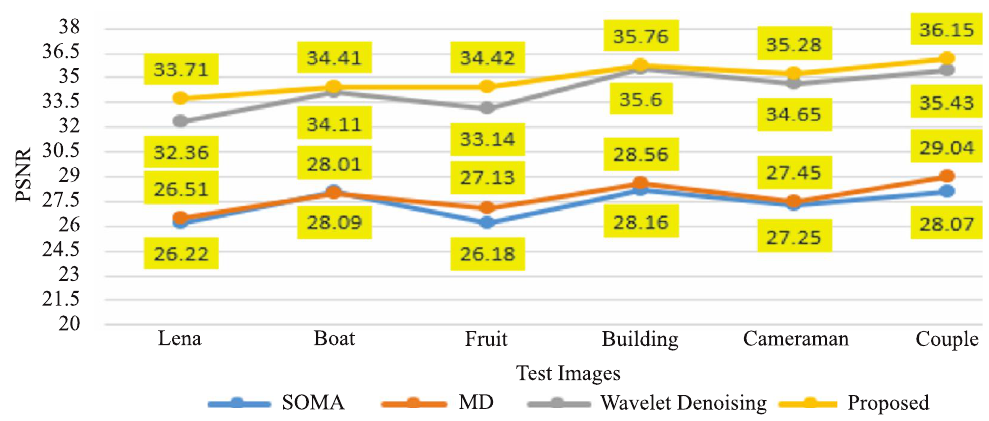
FIG. 9. GRAPHICAL COMPARISON OF PSNR OF DIFFERENT IMAGES USING DIFFERENT